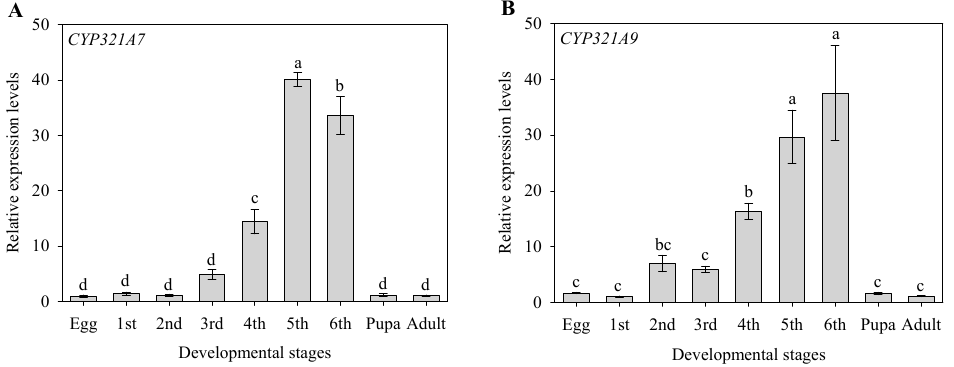
Figure 4. Expression of CYP321A7 ( A ) and CYP321A9 ( B ) at different developmental stages of Spodoptera litura . Instars are abbreviated (1st to 6th). Data were obtained by RT-qPCR as described in the Experimental Section. The β -actin gene was used as an internal reference to determine relative expression levels. Data shown are means ± SE (three biological replicates). Different letters above bars indicate significant differences ( p < 0.05) according to the Duncan’s multiple range test.